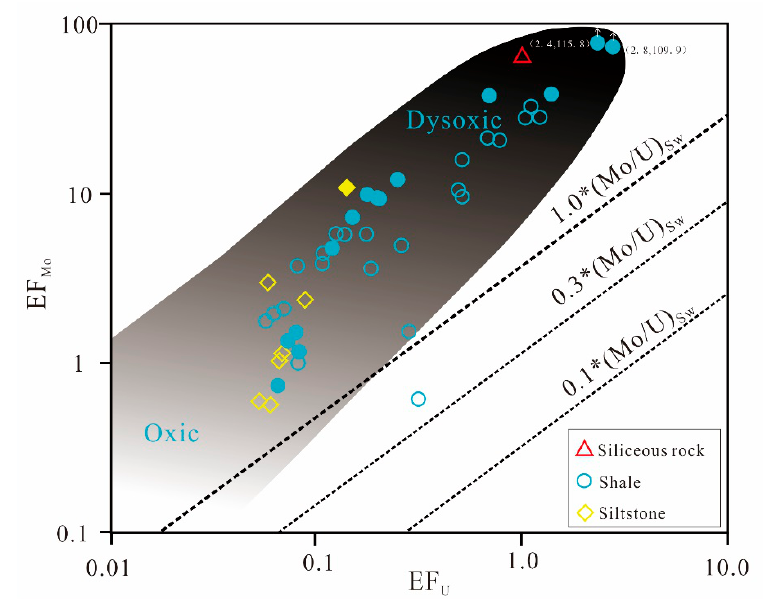
Figure 15. Cross plot of EF U vs. EF Mo . The diagonal dashed lines represent Mo/U molar ratios of the seawater (Sw). Hollow points are the samples from SQ-1 and solid points are the samples from CY-1.